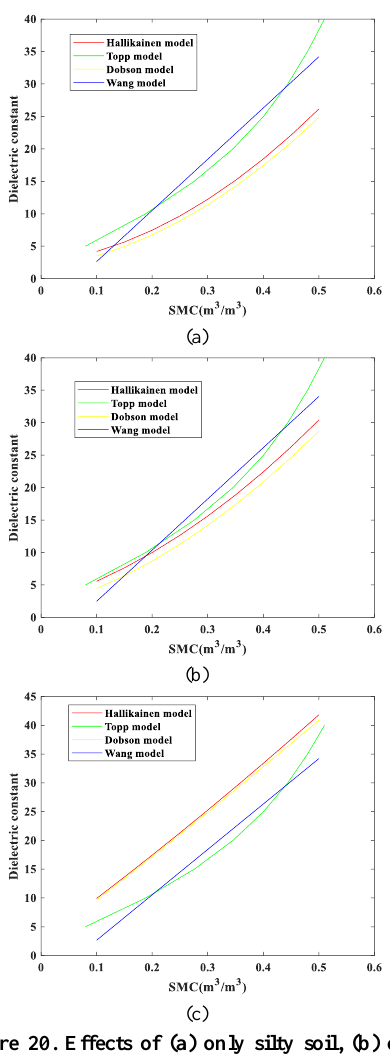
Figure 20. Effects of (a) only silty soil, (b) only clay, and (c) only sand soil on dielectric constant